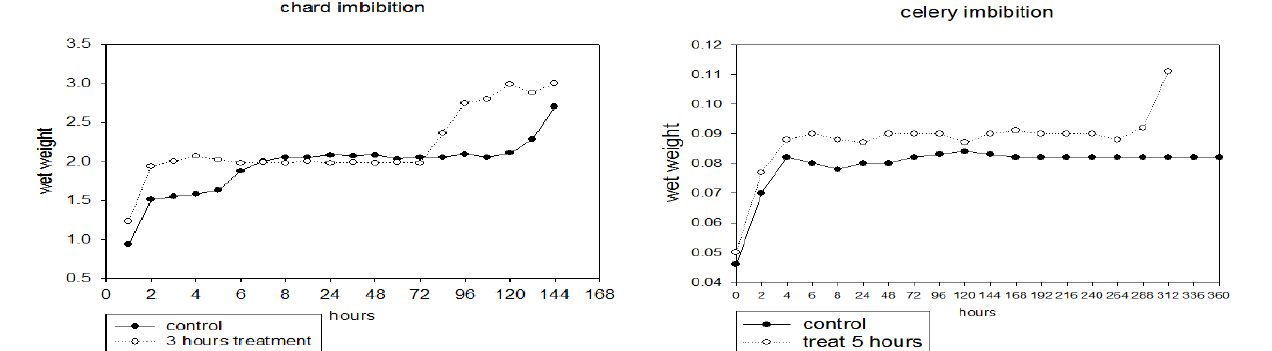
Fig. 4. Imbibition curve of control and the highest significant treatment of